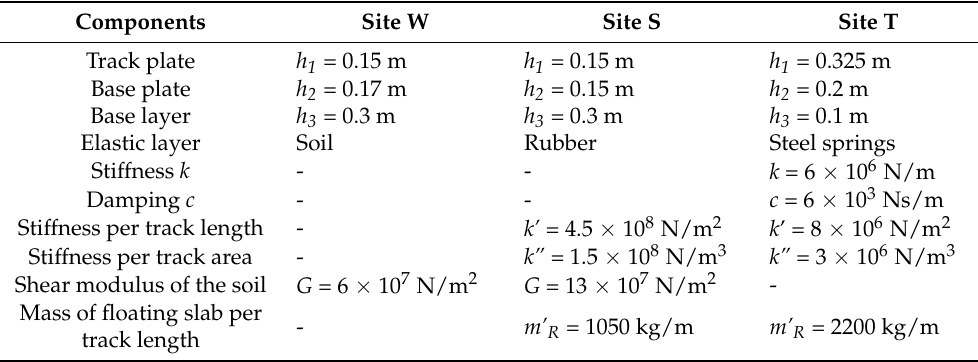
Table 2. Parameters of the track–soil systems at Sites W, S, and